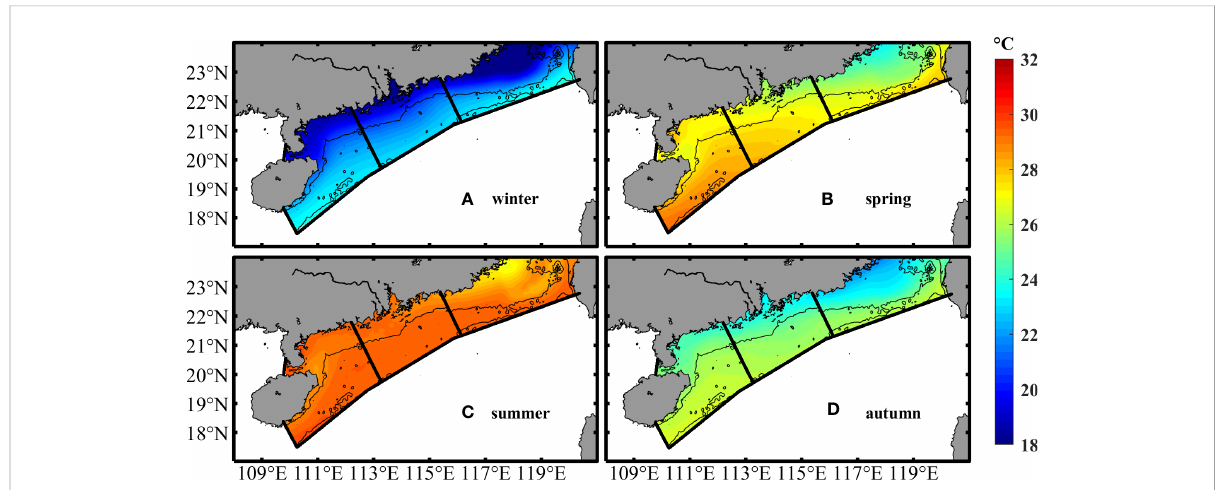
FIGURE 3 Seasonal SST averaged over 2002-2021 for (A) winter (January-March), (B) spring (April-June), (C) summer (July-September), and (D) autumn (October-December).The black lines are the 50-m and 200-m